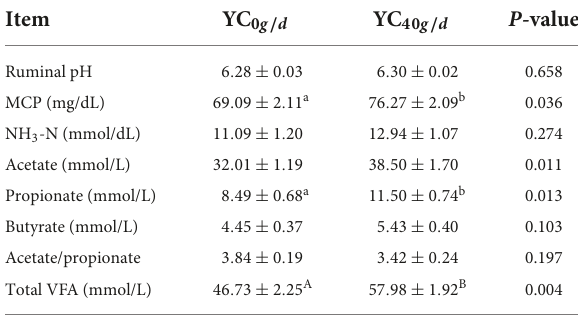
TABLE 4 Effect of feeding YC on rumen fermentation of growing